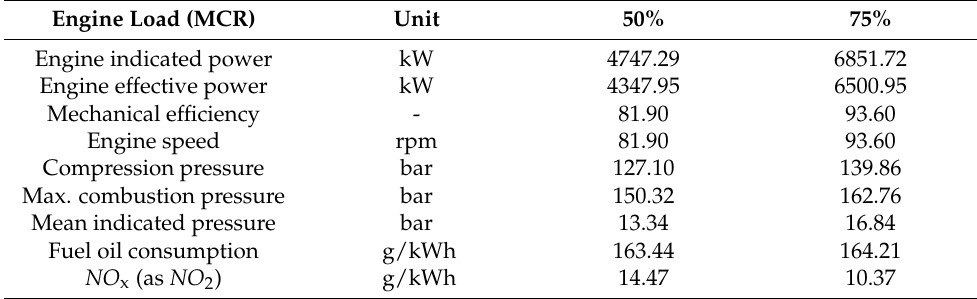
Table 7. Simulation model data [22].